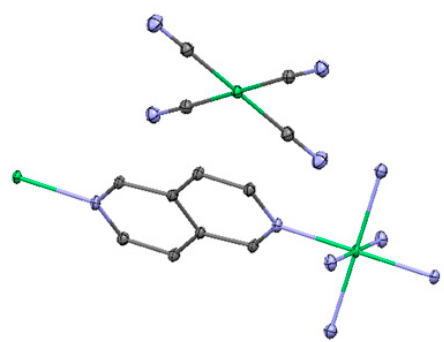
Figure 20. The basic motif of the Ni(Naph)[Ni(CN) 4 ] molecules (C-grey, N-blue, Ni-green; probability ellipsoids drawn at